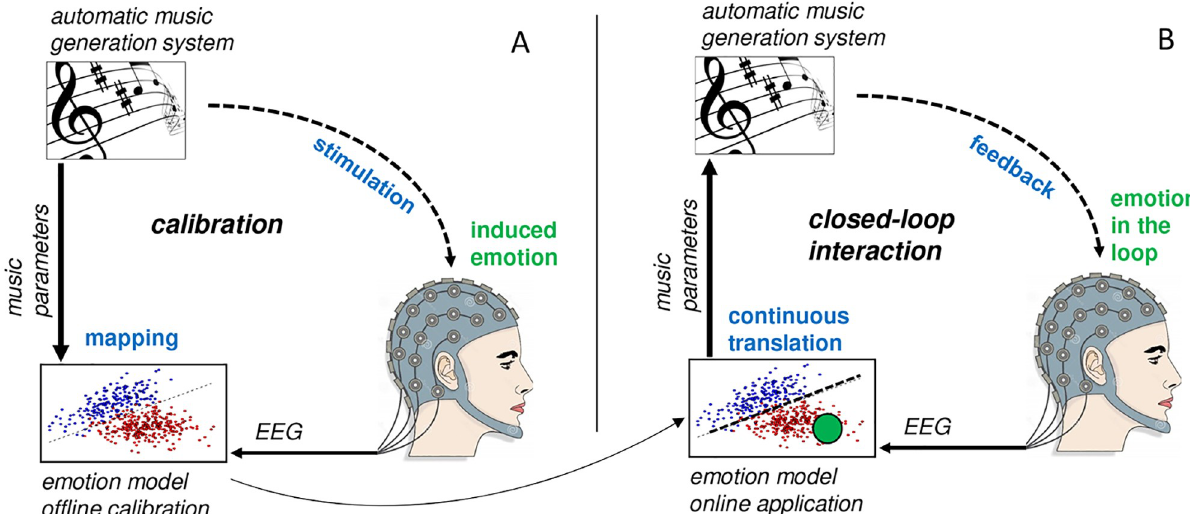
Fig 1. Conceptual illustration of the affective music BCI. (A) During calibration, the user is exposed to automatically generated patterns of affective music, and brain activity is measured simultaneously via EEG. EEG patterns are extracted and used to build a user-specific emotion model. (B) During online application, the obtained model is used to continuously translate the user’s brain activity into affective music, thereby closing the loop through continuous affective brain interactions.